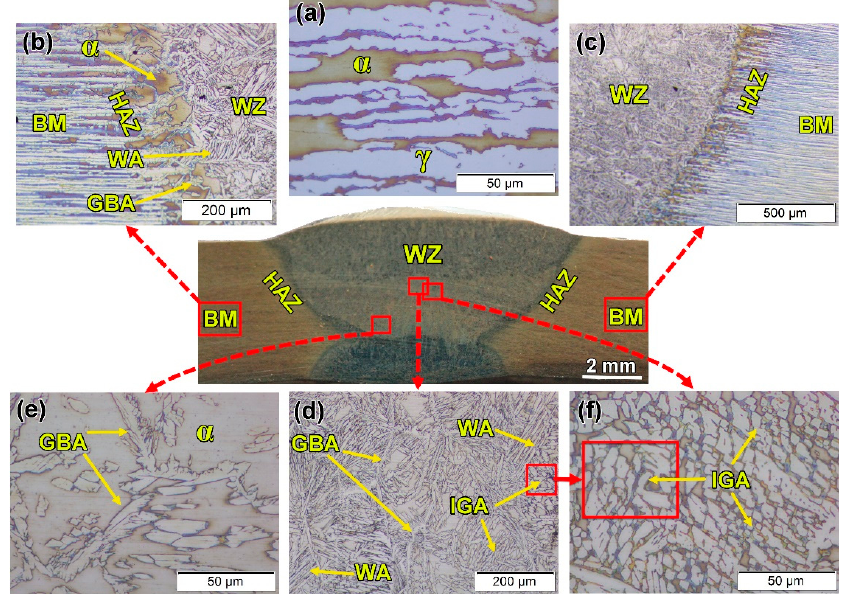
Figure 10. Optical microstructure of the GTAWed 2205 DSS butt joint using the V-shaped groove with root face and root gap: (a) BM, (b), (c) WZ/HAZ/BM at high and low magnifications, respec- tively, (d, e and f) WZ.